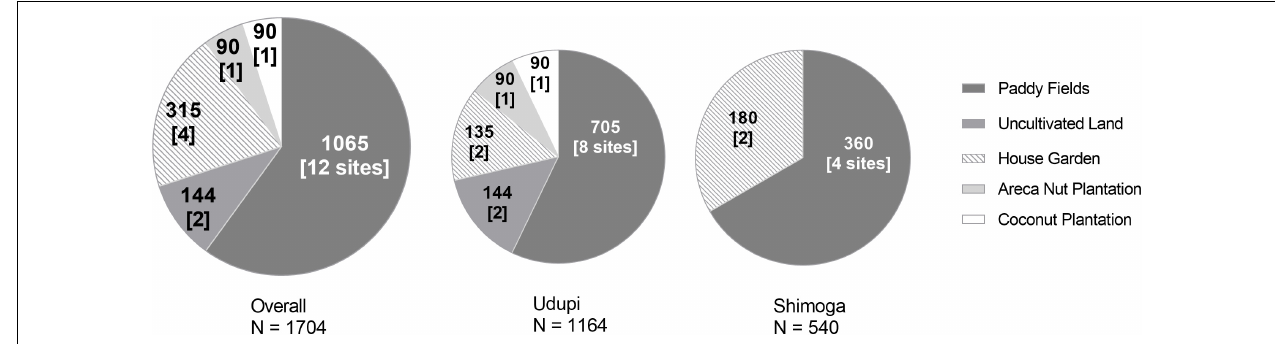
FIGURE 1 | Number and field quality of soil samples collected for the detection of Burkholderia pseudomallei. Each sector of the circle stands for a respective type of field. Sample counts are given as bold numbers; the number of sites is written in